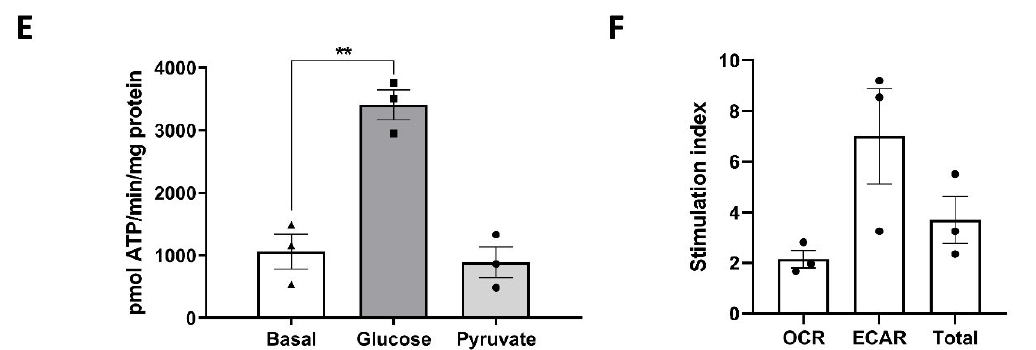
Figure 4. Human islets show increased OCR and ECAR in response to glucose stimulation. Human islets were cultured for 24 h following isolation prior to transfer into a 24 ‐ well islet capture plate for a further 24 h. ECAR and OCR was measured using the Seahorse XFe24 well analyser with additions of Glucose (25 mM), Pyruvate (1 mM), Oligomycin (20 μ M) or antimycin A (0.5 μ M) as indicated. ( A ) OCR is expressed as pmol/min/ μ g protein. ( B ) ATP production from OCR expressed as pmol ATP / min / mg protein. ( C ) ECAR is expressed as mpH/min/ μ g protein. ( D ). ATP production from ECAR expressed as pmol ATP/min/mg protein. ( E ). Total ATP production from OCR and ECAR. ( F ) Stimulation index was calculated as the ratio of stimulated (glucose) to basal ATP production (basal). n = 3. ** p < 0.01, *** p < 0.005 using a one ‐ way ANOVA followed by Bonferroni post hoc test.